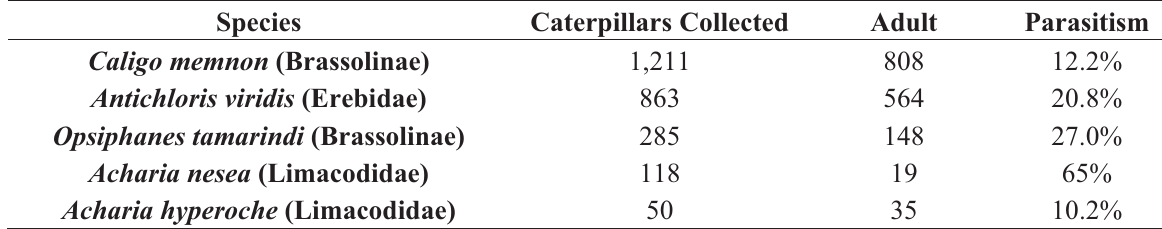
Table 3. The most abundant caterpillar species collected from all sites along with the number of each species collected, the number reared to adult, and the percent that were parasitized. Not all caterpillars collected resulted in adults or